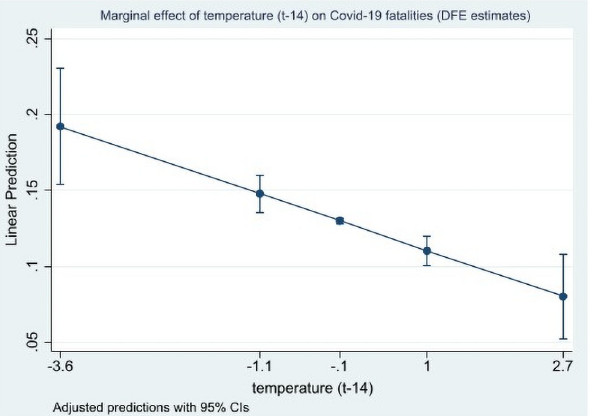
Fig 2. Marginal effects of temperature (t-14) on Covid-19 fatalities (direct effect with DFE estimates). Marginal effects are computed at the min, -1 std. deviation, mean, + 1 std. deviation, and max values of the (standardized) temperature